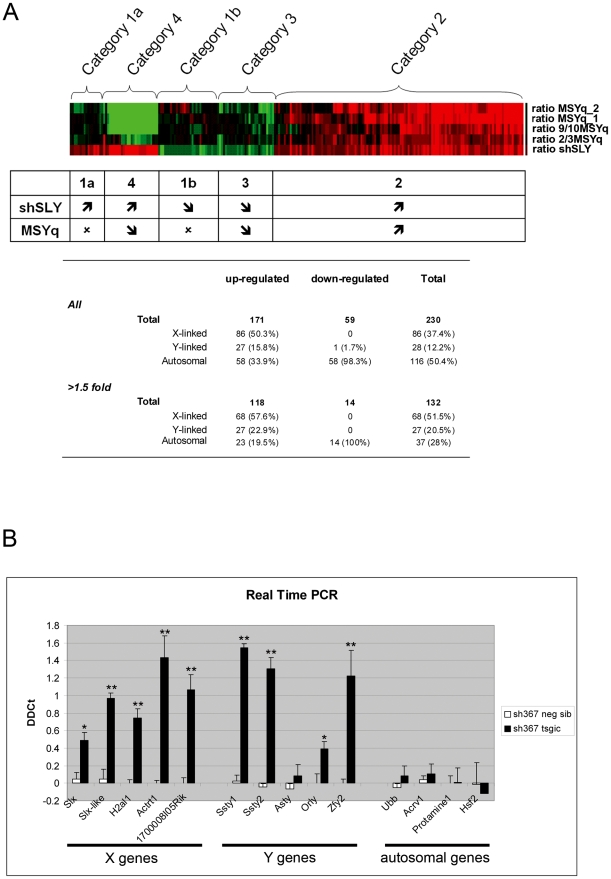
X-Y gene up-regulation in Sly-deficient mice.(A) Results from the microarray analyses performed on testes of Sly-deficient mice (shSLY 367) and MSYq-deficient mice (2/3MSYq−, 9/10MSYq−, and MSYq−). MSYq− samples came from 1- or 2-mo-old mice (respectively, MSYq_1 and MSYq_2 on the heat map). Differentially expressed genes were grouped into five categories based on their expression ratios across all genotypes. The red and green colors of the heat map represent gene up-regulation and down-regulation, respectively. Categories 1a and 1b represent genes found up-regulated (up arrows) or down-regulated (down arrows) in sh367 mice, without consistent changes (x) in MSYq− models. Genes in category 2 were up-regulated in sh367 and MSYq− mice with some dose-dependency with the extent of MSYq deletion. Genes in category 3 were down-regulated in sh367 and MSYq− mice with some dose-dependency with the extent of MSYq deletion. Finally, category 4 groups genes found to be up-regulated in sh367 mice and down-regulated in MSYq− mice, with a very strong dose-dependency with the extent of Y deletion. The table indicates the number and the chromosomal distribution of the genes that were found differentially expressed in sh367 mice compared to nontransgenic siblings. (B) Analysis of gene expression in testis of Sly-deficient mice (sh367 tsgic) and controls (neg sib) by real-time PCR. Values plotted are ΔΔCt±standard errors. One or two asterisks indicate significant difference from the control value (respectively, p<0.05 or p<0.005; t-test).